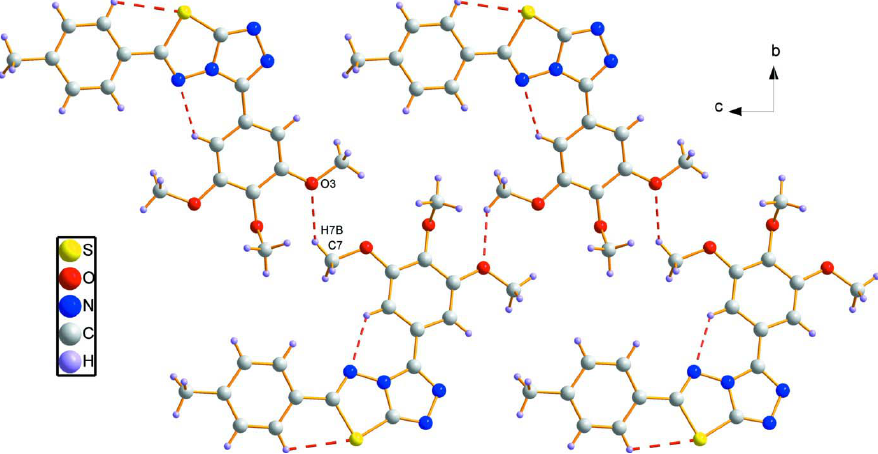
The molecular structure of the title molecule, with the atom-numbering scheme. Displacement ellipsoids are drawn at the 50% probability level.